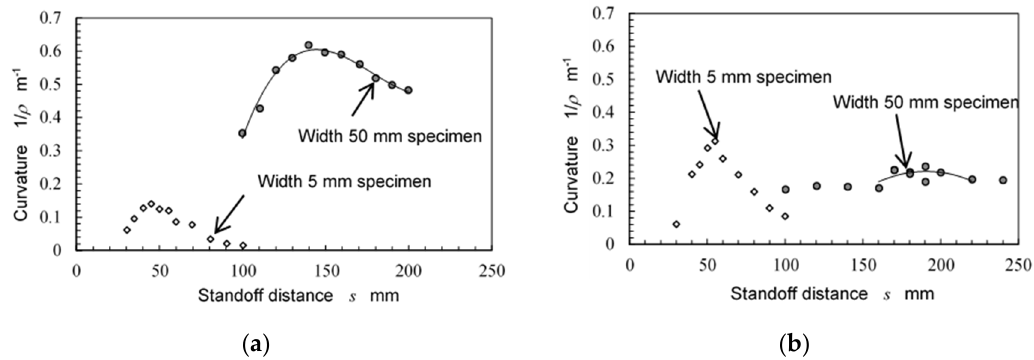
Figure 13. Peening intensity as a function of standoff distance [97]: ( a ) 40 and ( b ) 60 MPa. Reproduced with permission from The Water Jet Technology Society of Japan.